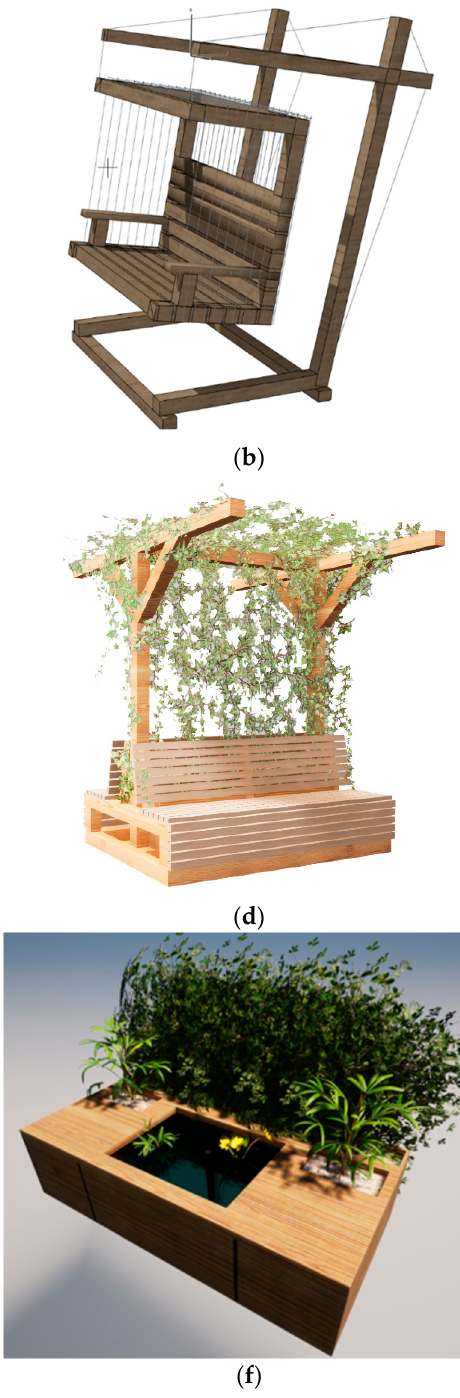
Figure 4. First drafts of the open space greening systems of the participating students of the Camillo Sitte Bautechnikum in Vienna: ( a ) greened pergola “GreenClassroom”; ( b ) plantable hanging chair “Green Trio”; ( c ) raised bed “The Vessel”; ( d ) pergola “T-Bench”; ( e ) pergola with playground equipment “Place Evergreen”; ( f ) greened fountain.